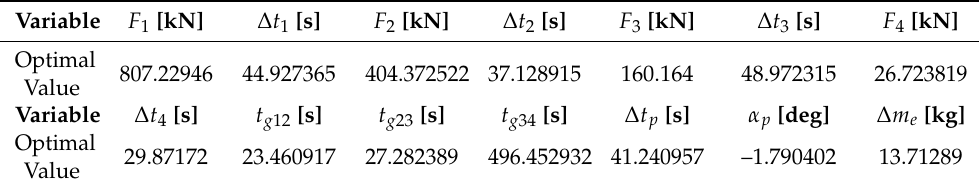
Figure 4. Optimization results for air-launched rockets. ( a ) Time–height curve, ( b ) Time–local flight path angle curve, ( c ) Time–thrust curve, ( d ) Time–Mach number curve, ( e ) Time–mass curve, ( f ) Time–dynamic pressure curve, ( g ) Three-stage rocket objective function convergence curve, ( h ) Four-stage rocket objective function convergence curve. Table 4. Optimal values of design variables of ground-based vertical